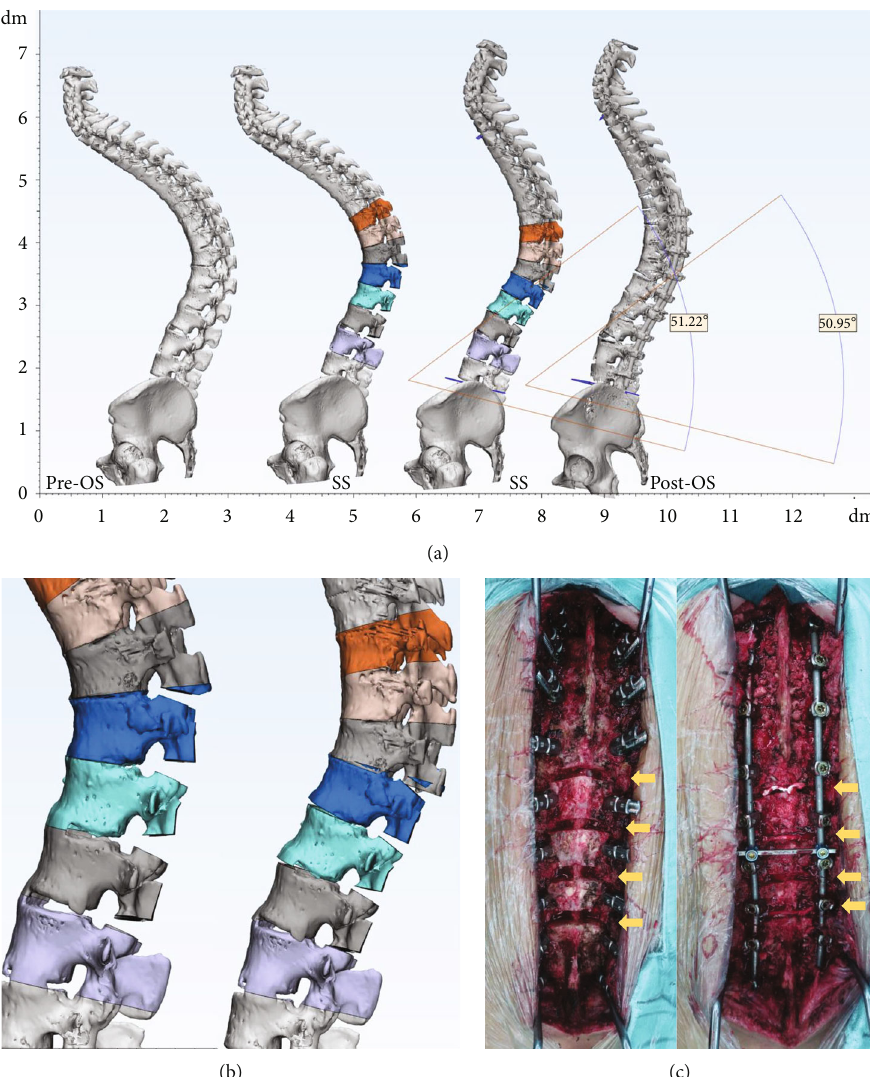
Figure 3: 3D simulation of multilevel PCO. (a) Sagittal view of the 3D spine models. (b) Partial view of PCO simulation. (c) Intra-op photographs. Yellow arrows indicated osteotomy